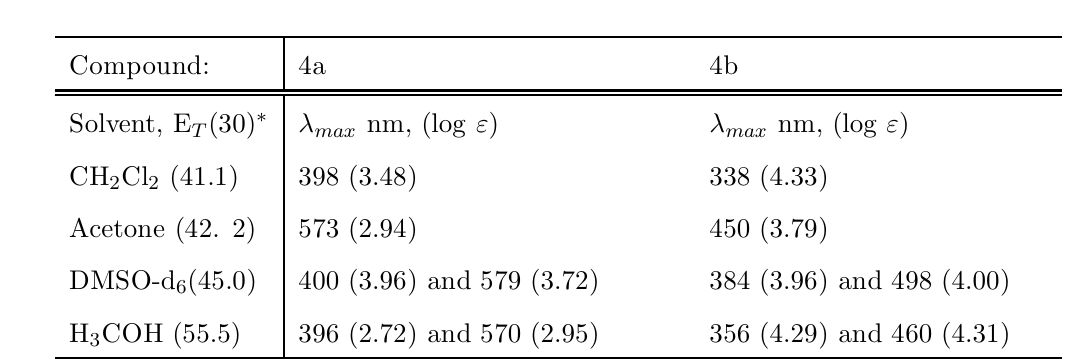
Table 2 UV-VIS spectra of compounds 4a,b; ¤ Dimroth-Reichardt parameters [13]